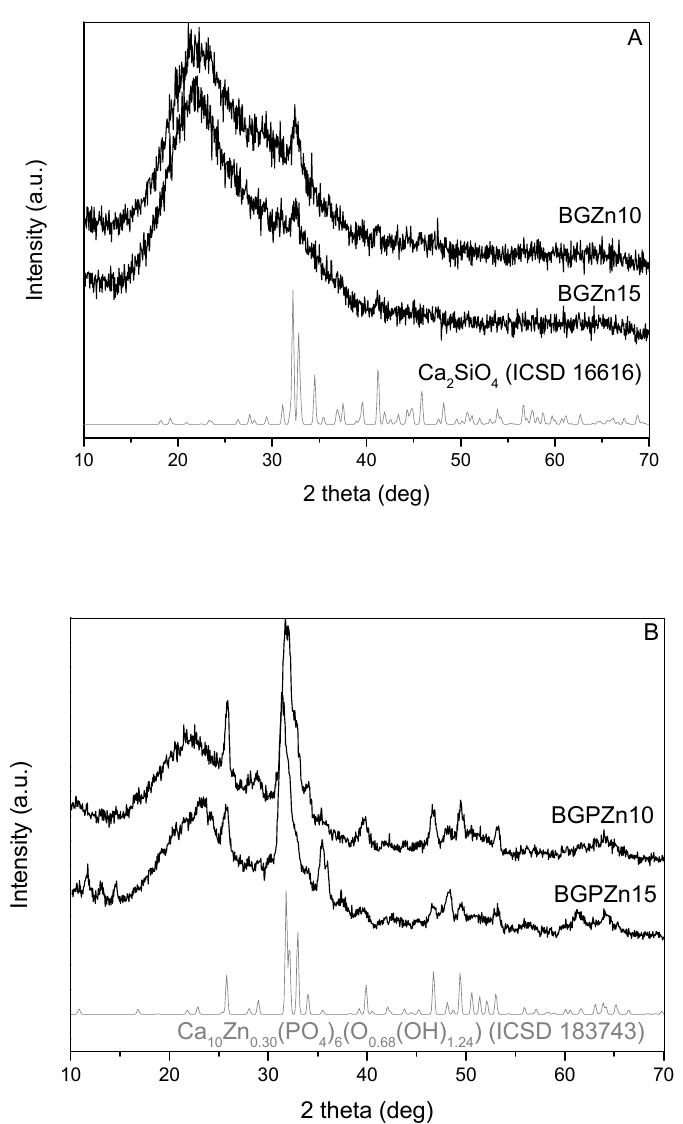
Figure 4. XRD of particles doped with Zn: ( A ) particles without P and ( B ) particles with